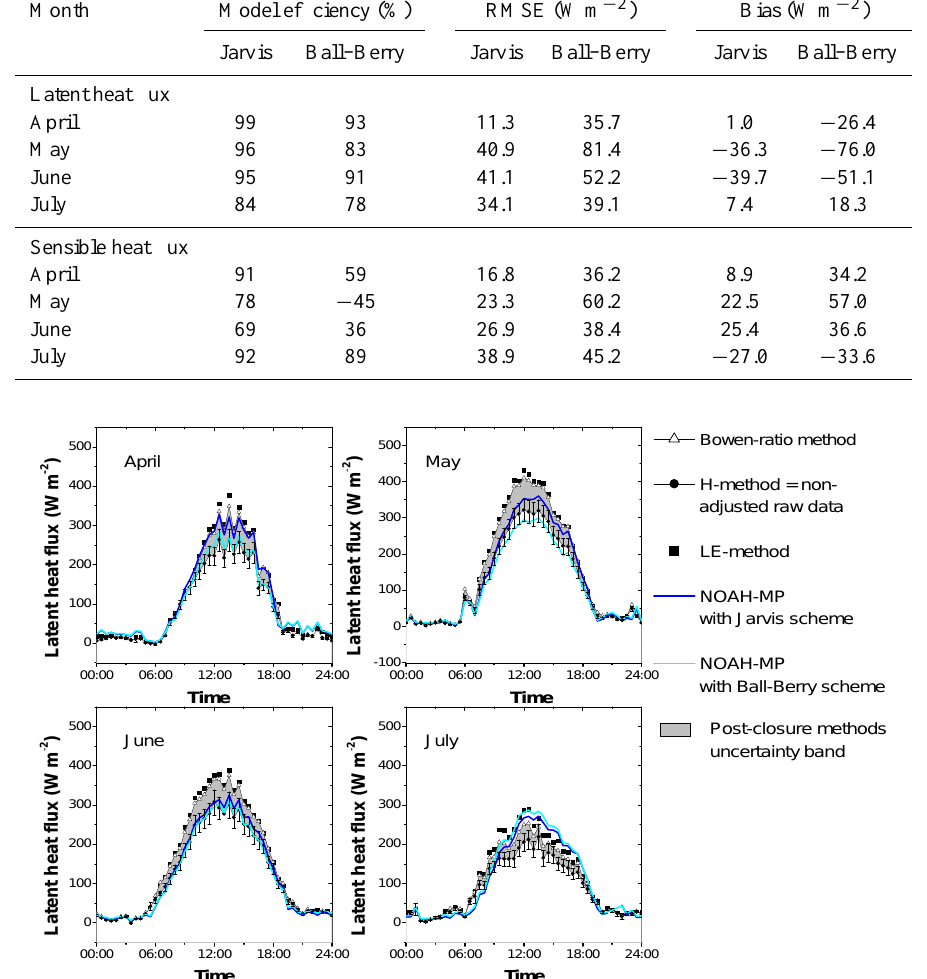
Figure 7. Measured and simulated monthly average diurnal cycles of latent heat flux over a winter wheat stand in southwest Germany. For modelling, the NOAH-MP land surface model was used in two configurations. The stomatal resistance was computed either with the empirical Jarvis scheme or the photosynthesis-based Ball–Berry scheme. The grey band shows the post-closure methods uncertainty band computed as the difference between the raw and Bowen ratio-adjusted fluxes. The error bars indicate the random measurement error. In some cases, the error bars are smaller than the size of the symbol and therefore not